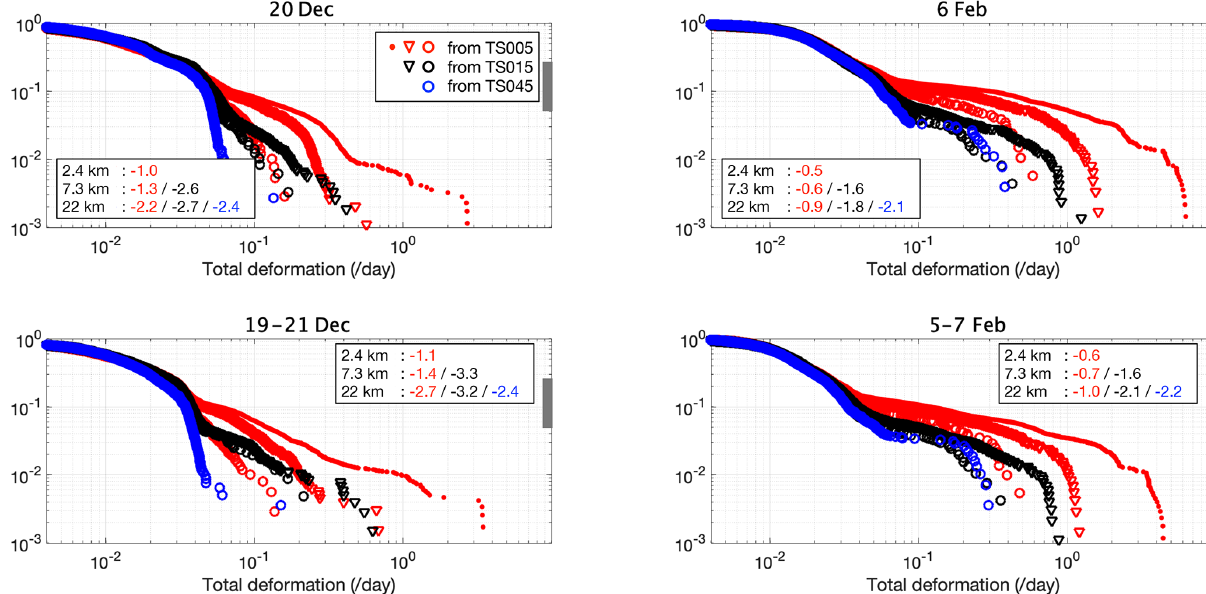
Figure 9. Cumulative density functions for the total deformation rates on 20 December and 6 February. The region of study is outlined in Figs. 7 and 8. Daily rates are shown in the first row, and 3d rates are in the second row. Colors indicate the cumulative PDFs from the model results from different grids (red: TS005; black: TS015; blue: TS045). With spatial coarsening of TS005, we compute the cumulative PDF at the spatial scales corresponding to the native resolution of TS015 and TS045. In turn, the spatial coarsening with TS015 is also applied to compute the cumulative PDFs at the equivalent resolution of TS045. The three spatial scales are marked by different shapes: 22km (or TS045’s native resolution) in circles; 7.3km (or TS015’s native resolution) in triangles; 2.4km (or TS005’s native resolution) in dots. Slopes are computed for the range of cumulated probability between 0.05 and 0.25 for all cumulative PDFs (marked out in grey in each panel), which correspond to the 95th and 75th percentile of the deformation fields, respectively. All results are based on experiments with NDTE =